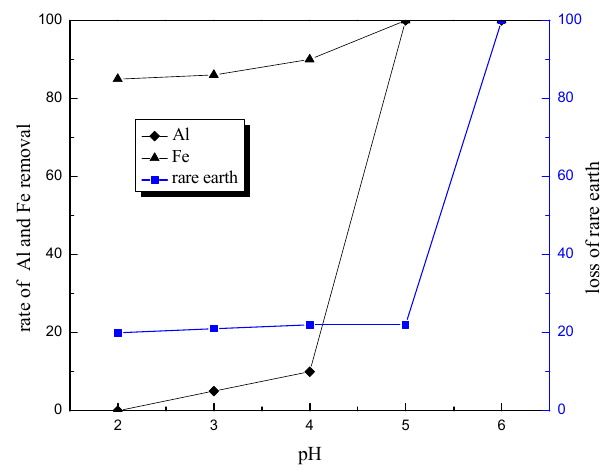
Figure 6. Effects of pH on the yields of impurities and rare earth metals.